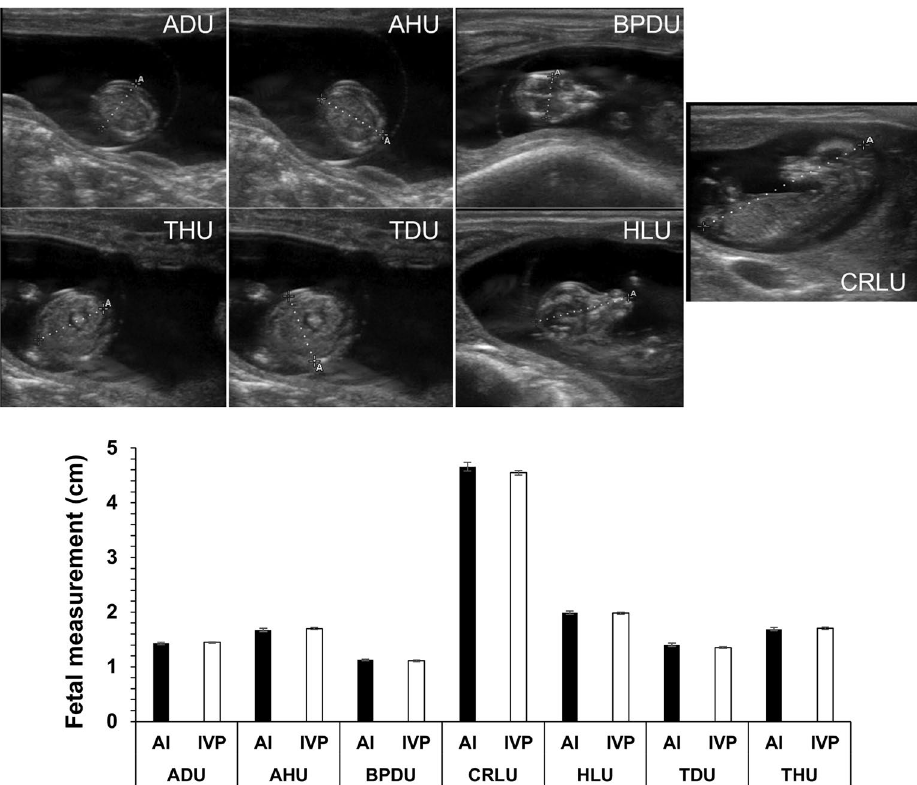
Figure 1. D55 fetal morphometry. Top Sagittal views of the ultrasound images taken on D55 of gestation. U ultrasound, AH abdominal height, AD abdominal diameter, BPD biparietal diameter, CRL crown rump length, HL head length, TD thoracic diameter, TH thoracic height. Bottom Comparison of ultrasound measurements between all the AI (n = 26) and IVP (n = 89) fetuses in this study. No statistical differences were detected between groups. AI artificial insemination (i.e., control), IVP in vitro produced